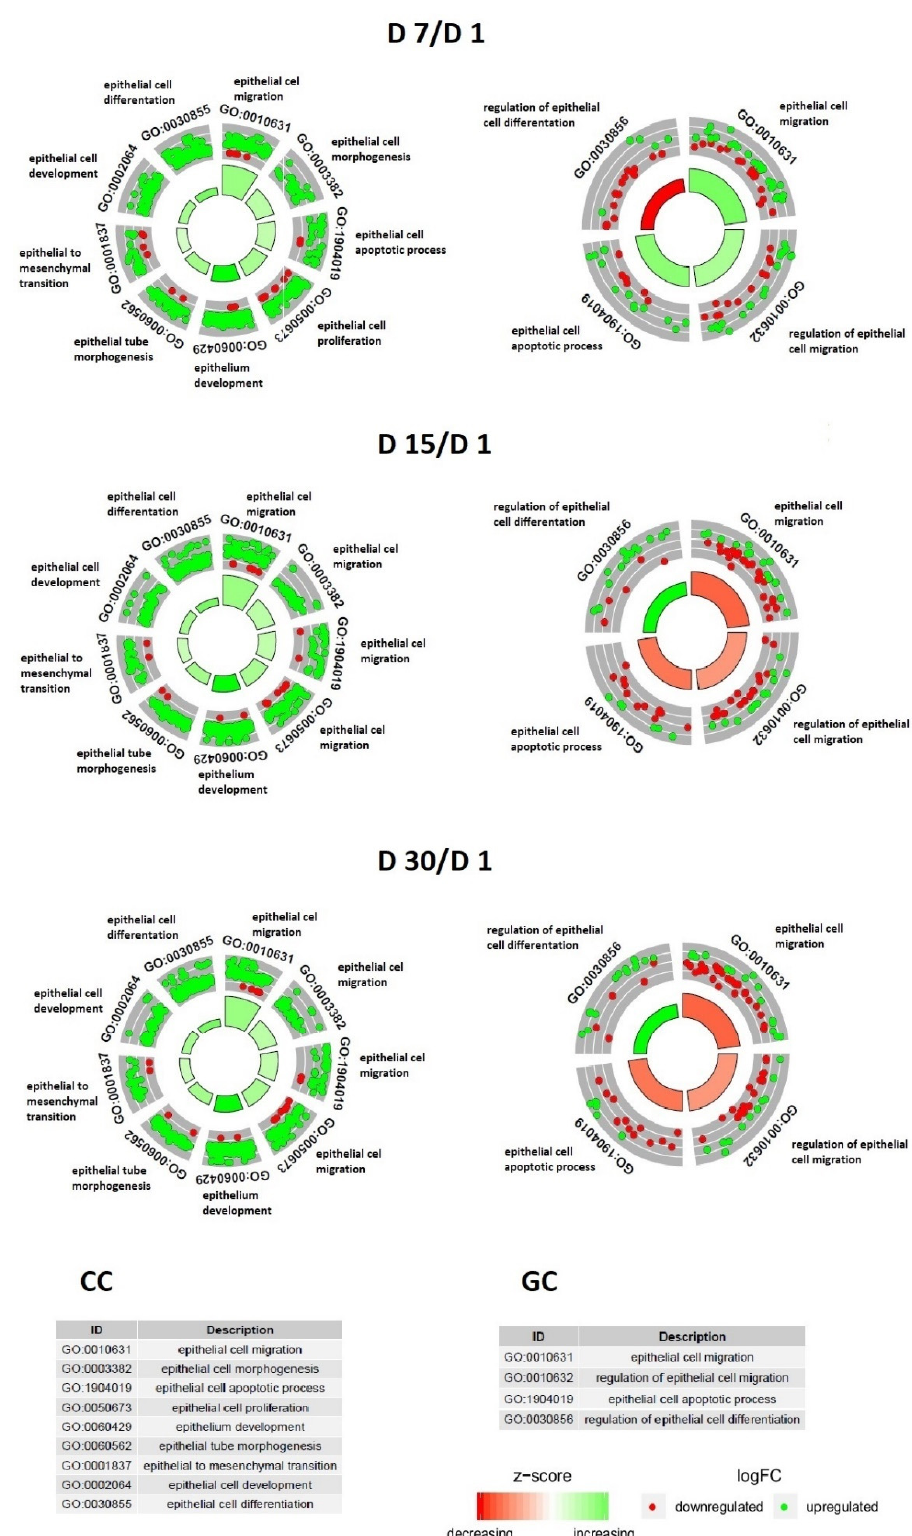
Figure 2. The circle plot showing the differentially expressed genes and z-scores. The outer circle represents a scatter plot for each term of the fold change of the assigned genes. Green circles display up-regulated genes, and red circles display down-regulated genes. The inner-circle illustrates the z-score of each GO BP term. The width of each bar corresponds to the number of genes within the GO BP term, and the color corresponds to the